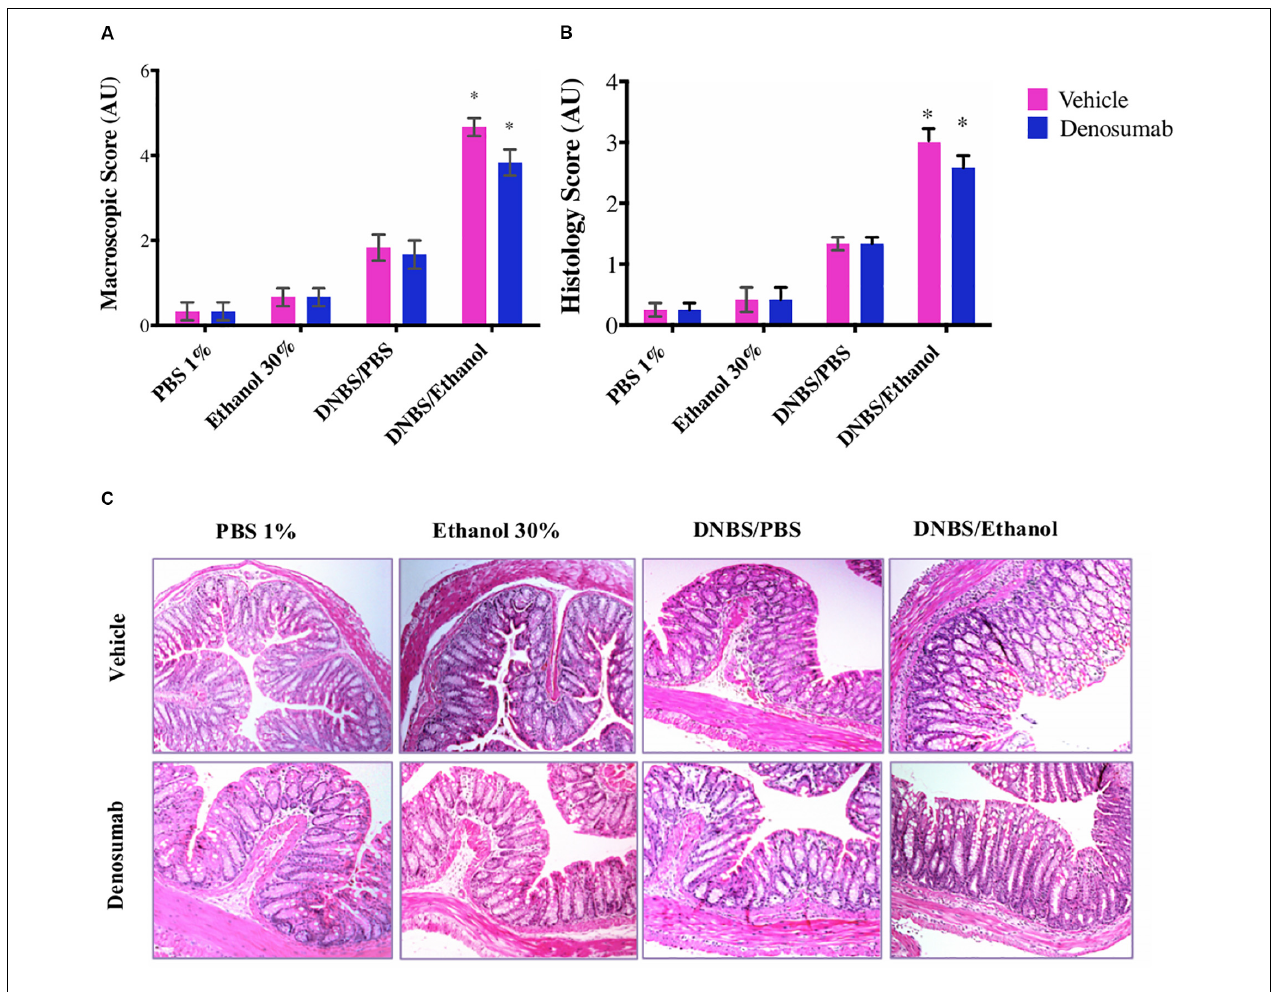
FIGURE 3 | The effects of DNBS/Ethanol-induced colitis and denosumab treatment on macroscopic score and representative hematoxylin and eosin (H&E) stained colon mucosa, histologic and score. (A) Colonic macroscopic score. (B) Histological scores. (C) The H&E stained colon mucosa section showed a significant disruption of epithelial integrity, necrosis and transmural infiltration of immune cells. DNBS/Ethanol group increased ( p = 0.03) the histological score while denosumab did not alleviate colitis. AU: arbitrary unit. Error bars are shown as SEM. * p < 0.001 when compared with other induction models within the denosumab or vehicle group calculated using SAS MIXED procedure and illustrated by Prism using two-way ANOVA. n = 6 mice per